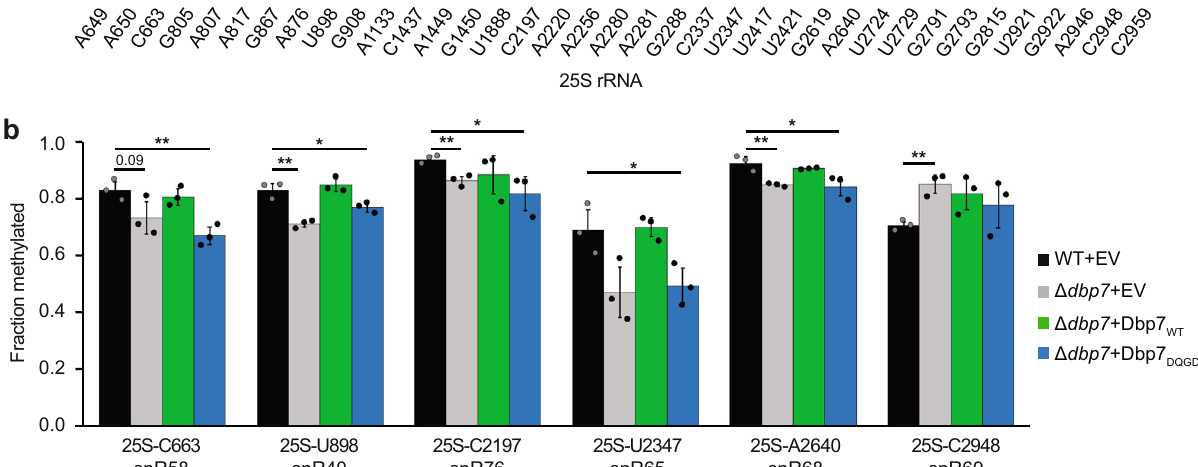
p = 0.049087; U2347 WT + EV vs DQGD p = 0.048903; C2948 WT + EV vs DQGD